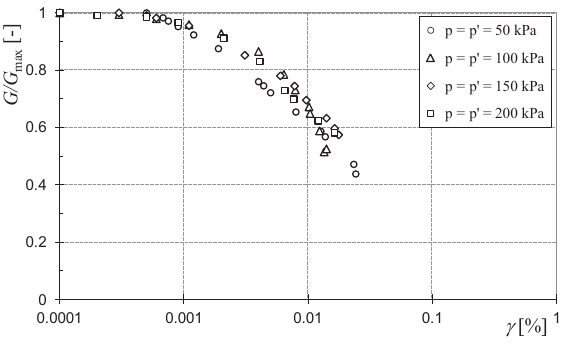
Fig. 6. The results of the RC tests for sample S5919.